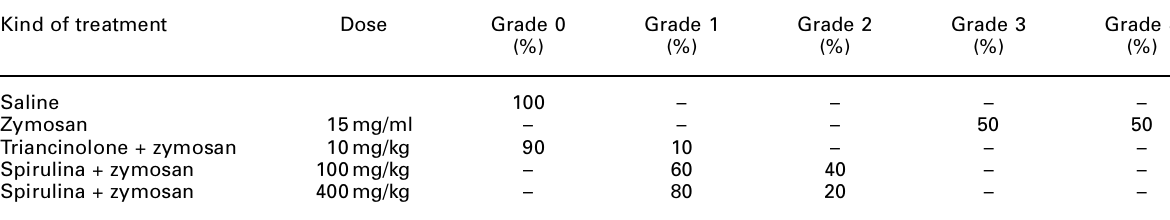
Table 2. Articular histological lesions of the knee in zymosan-induced arthritis in mice treated with Spirulina Kind of treatment